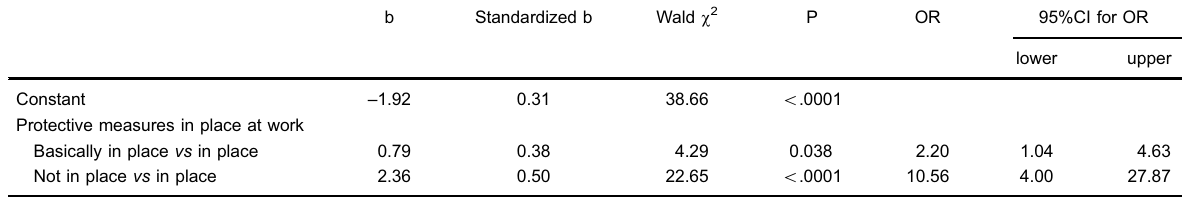
Table 4. Multivariate regression analysis of factors associated with insomnia in healthcare workers during the COVID-19